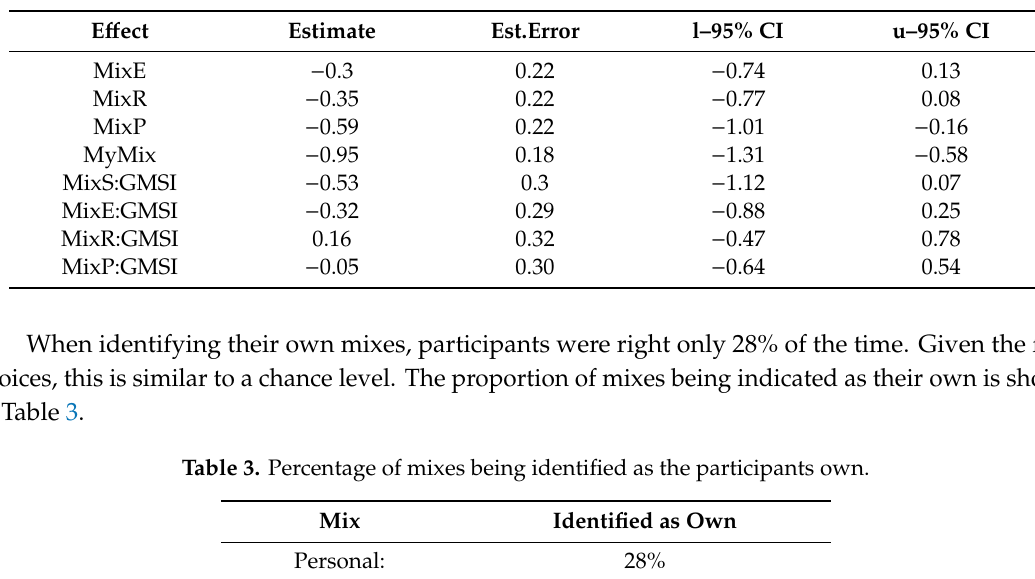
Table 2. The output of the Bayesian model with MixS as the reference level. The Estimate is the mean of each e ff ect’s posterior distribution, l–95% and u–95% are the lower and upper bounds of the e ff ects’ 95% credibility interval (the data tell us that the e ff ect’s true size has a 95% probability of falling in this interval), respectively. If the 95% CI (Confidence Interval) does not cross zero, the e ff ect can be considered “significant”. MixY:GMSI e ff ects are the interaction e ff ects between Goldsmith Music Sophistication Index (GMSI) and the specified mix ratings. MixS = Sawtooth Mix, MixP = Personal Mix, MixE = Expert Mix, MixR = Random Mix.Population-Level E ff ects.